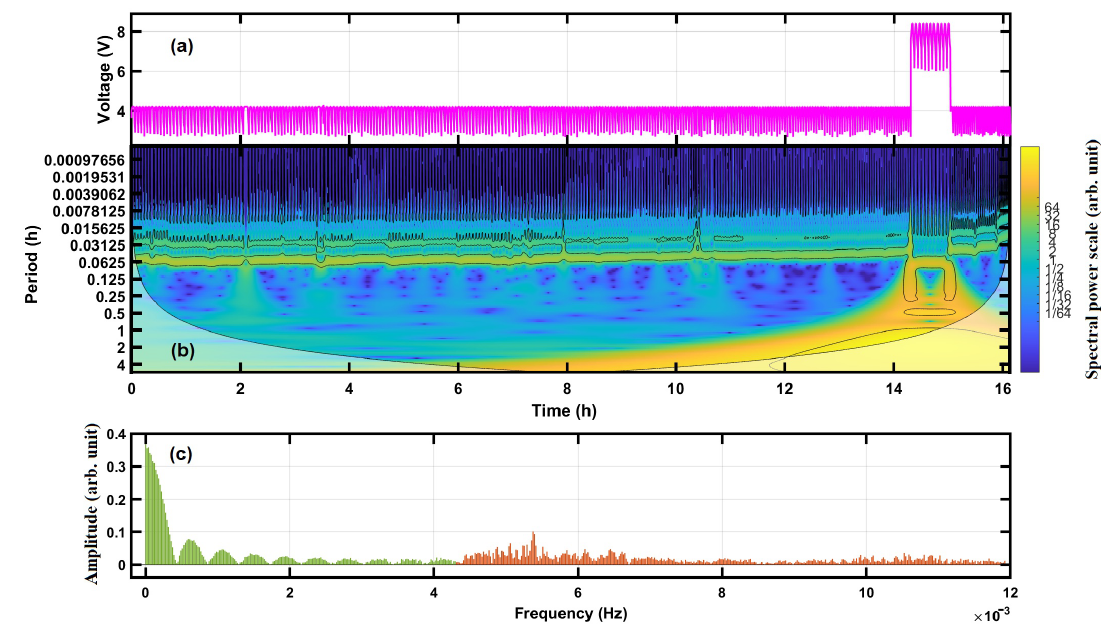
Figure 4. ( a ) Voltage, ( b ) wavelet spectral power, and ( c ) Fourier spectrum of the cycling test performed by CALCE to the prismatic cell tested a 25 ◦ C (PC-25C). The frequencies in green indicate the frequencies preceding the failure, while those in orange indicate the frequencies late to the